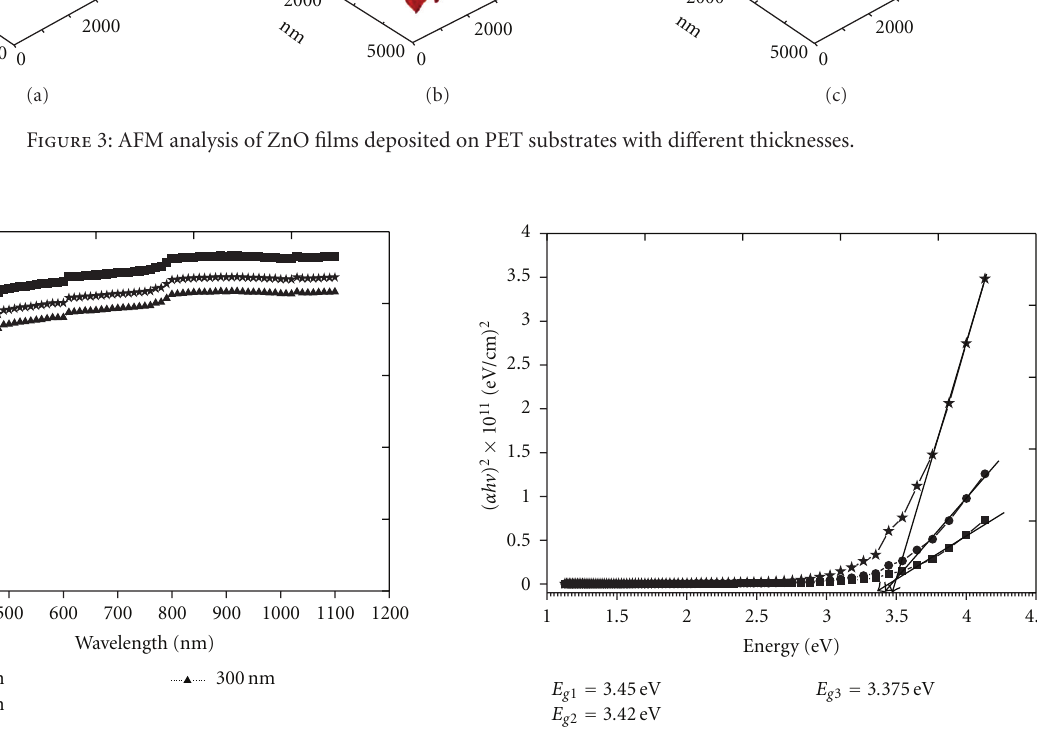
Figure 5: A plot of ( αh ν ) 2 as a function of photon energy for ZnO thin films deposited on PET substrates with di ff erent